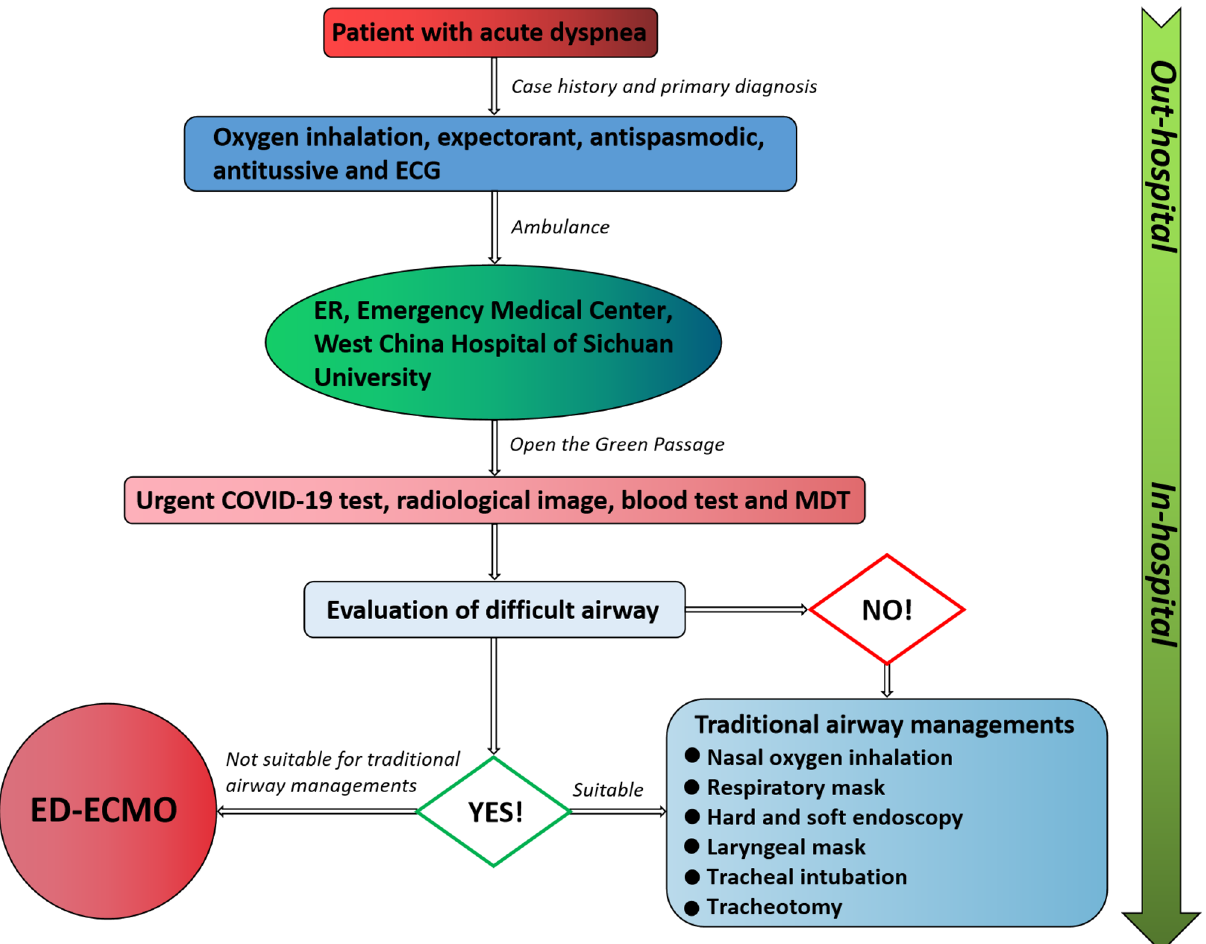
Figure 1. Green passage for patient with possible difficult airway. ED, emergency departments; ER, emergency room; ECG, electrocardiogram; ECMO, extracorporeal membrane oxygenation; MDT, multidisciplinary team.